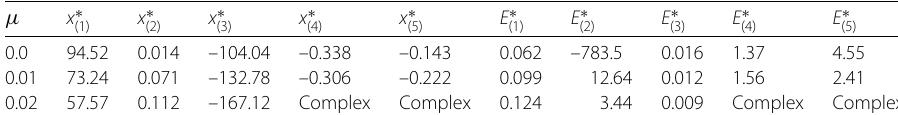
Figure 7 Plot E ∗ vs x ∗ for the case (i) with μ = 0.2